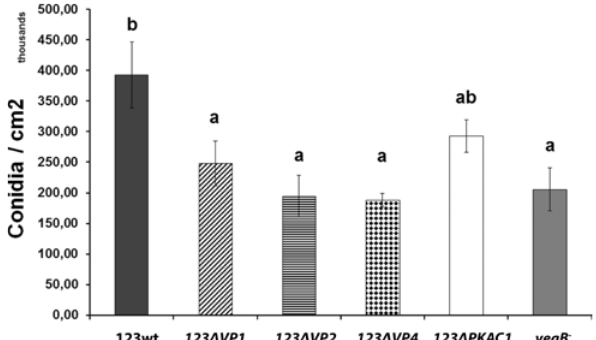
Figure 3. Production of conidia by Verticillium dahliae wild type (123wt-r2), mutant veg B- and double disruptants 123Δ VP1 , 123Δ VP2 and 123Δ VP4 . Error bars indicate standard errors calcu- lated for five replicates. Values calculated for each treatment were subjected to analysis of variance and means were separated by Fish- ers’s least significant deifference (LSD) procedure. Columns with different letters are statistically different at P ≤ 0.05.